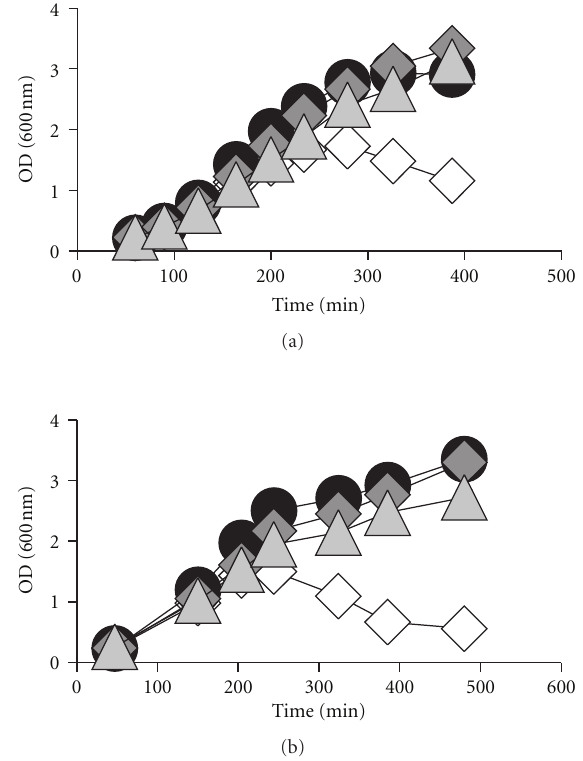
Figure 5: E ff ect of maltotriose on viability. (a) Growth curves of the ompR malT con glgP mutant (strain AJW3902) grown in LB at 37 ◦ C without sugars (white diamonds) or supplemented with glucose (black circles), maltose (dark gray diamonds), or sorbitol (light gray triangles). Values represent the mean of triplicates. Error bars are only shown when greater than the symbol. (b) Growth curves of the ompR malT con malZ mutant (strain AJW3888) grown in LB at 37 ◦ C without sugars (white diamonds) or supplemented with glucose (black circles), maltose (dark gray diamonds), or sorbitol (light gray triangles). Values represent the mean of triplicates. Error bars are only shown when greater than the